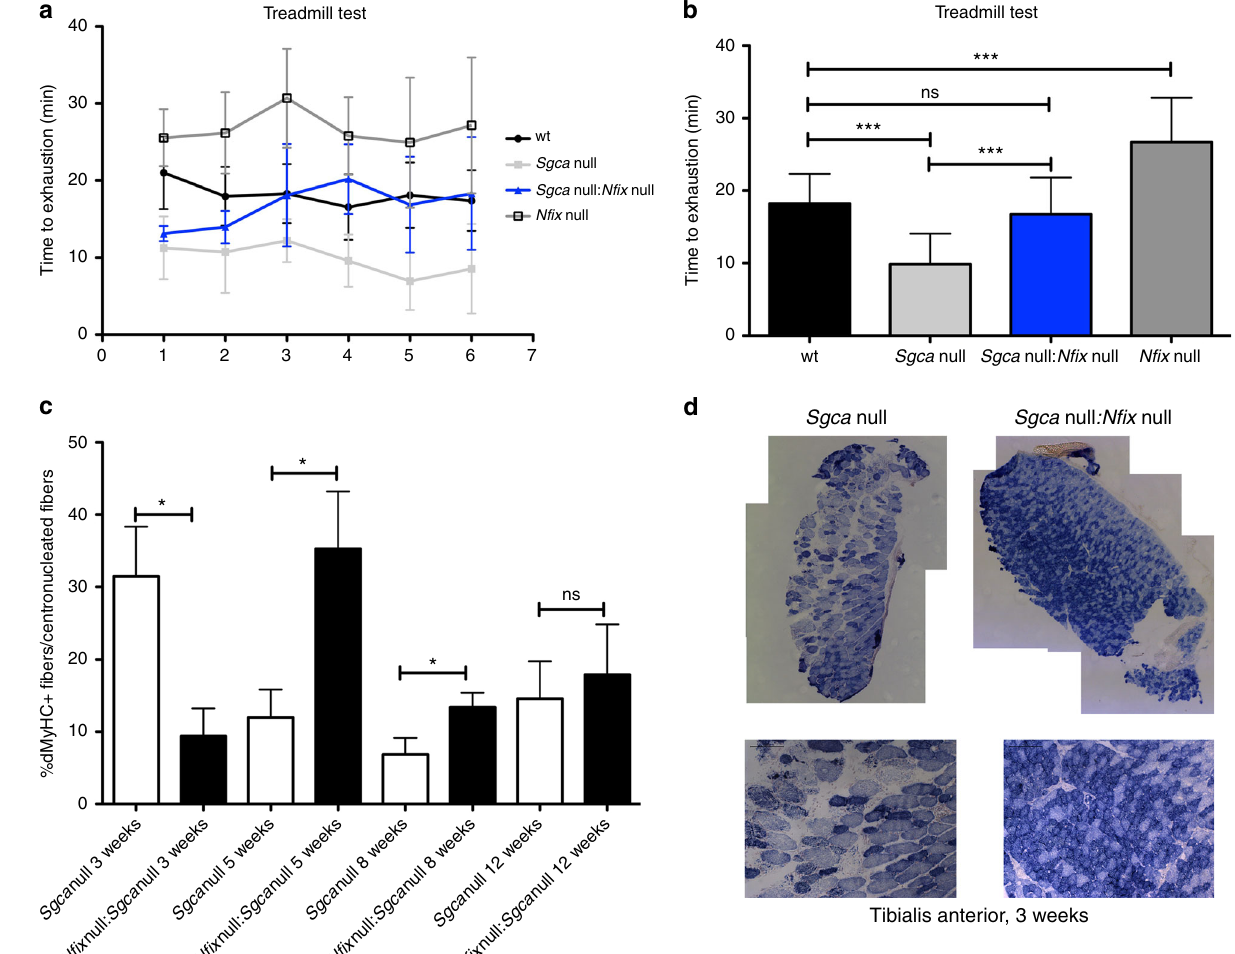
Fig. 4 Sgca null: N fi x null mice show improved functionality, an oxidative phenotype, and delayed regeneration. a , b Treadmill test on WT, Sgca null, Sgca null: N fi x null, and N fi x null mice. a represents the performance pro fi le over time, while b shows the totality of the measurements; N = 6 measurements per 7 WT, 4 Sgca null, 3 Sgca null: N fi x null, and 4 N fi x null mice. Mean ± SD; one-way ANOVA with Bonferroni post-test, *** P < 0.001. ns, non signi fi cant. See also Supplementary Movie 1 for an example of a typical run. c Percentage of developmental myosin heavy chain positive fi bers out of the centrally nucleated fi bers at different time points. N = 8 Sgca null and 8 Sgca null: N fi x null mice at 3 weeks, N = 11 Sgca null and 11 Sgca null: N fi x null mice at 5 weeks, N = 11 Sgca null and 11 Sgca null: N fi x null mice at 8 weeks, and N = 10 Sgca null and 10 Sgca null: N fi x null mice at 12 weeks; mean ± SEM; t test, * P < 0.05, * P < 0.001. d Entire tibialis anterior muscle section reconstructions and higher magni fi cations showing SDH staining at 3 weeks of age; N = 13 Sgca null and 6 Sgca null: N fi x null mice. Scale bar 100 μ